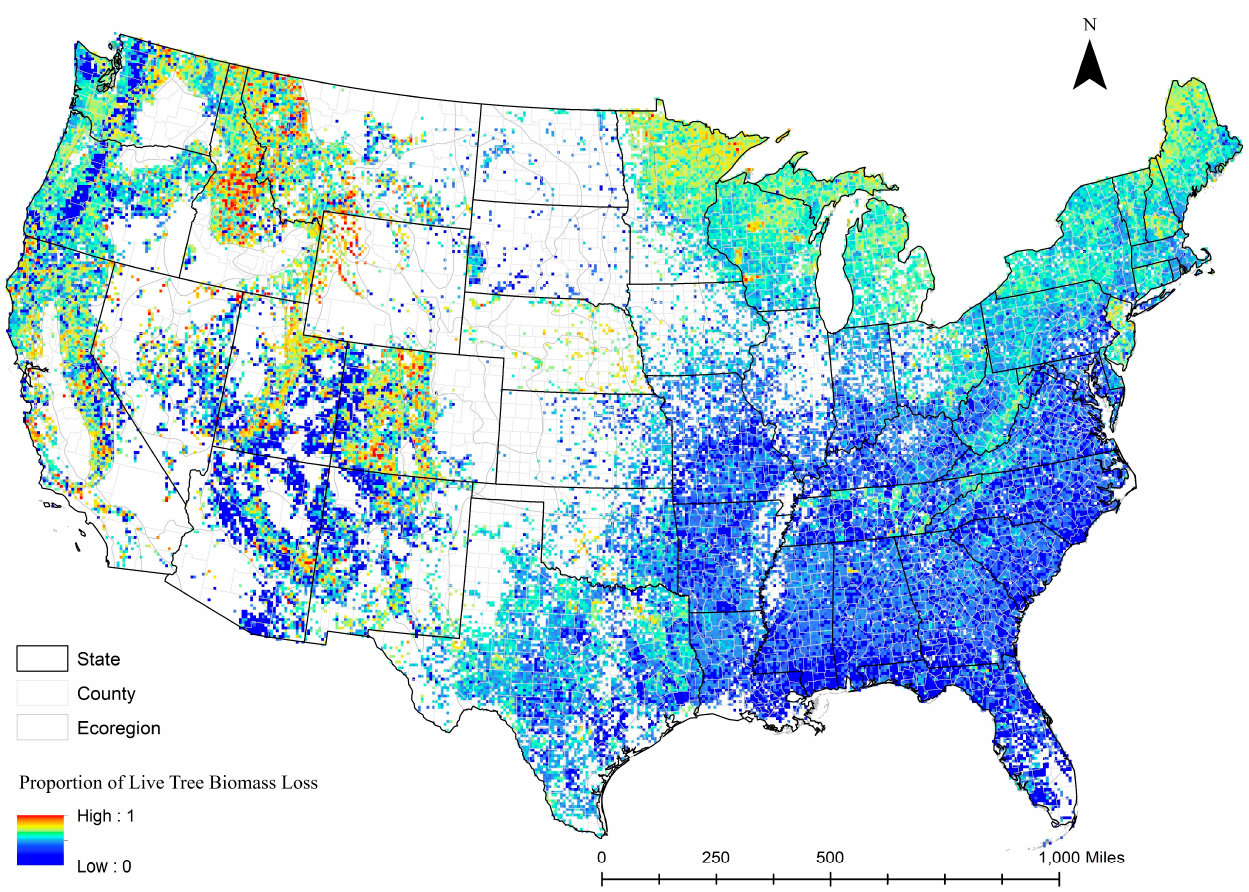
Figure 5. Proportion of live tree mortality in FIA forest plots predicted using TreeBio-Loss equation across the continental United States. (Raster map download link: https://www.canr.msu.edu/socioeconomics/econ/data, accessed on 13 November 2022).